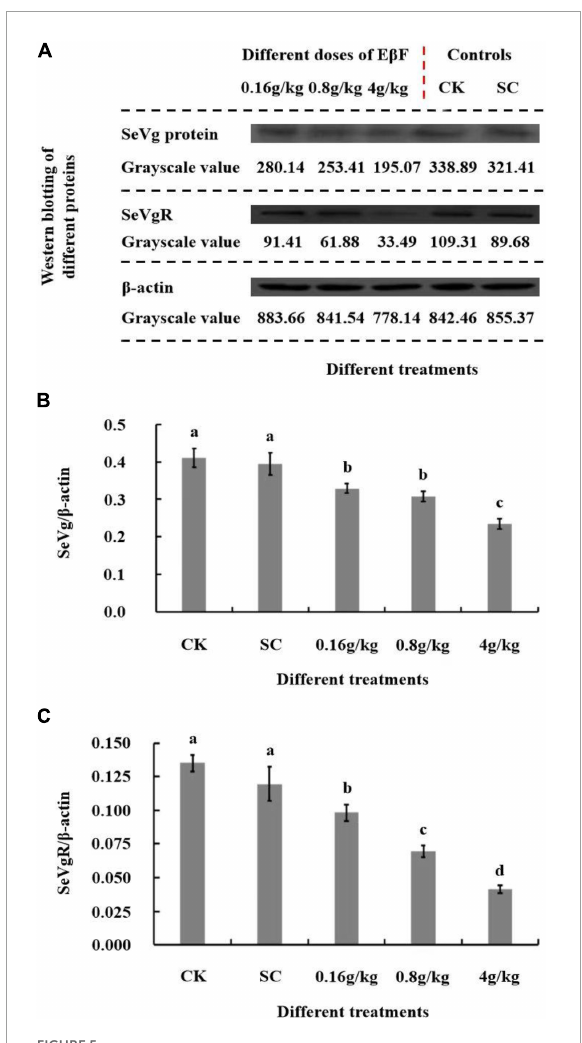
FIGURE5 The Western blot assay showed the relative expressions of SeVg and SeVgR proteins in female adults of S. exigua after E β F treatments at different doses. (A) The Western blot pictures of SeVg and SeVgR proteins in female adults of S. exigua after E β F treatments at different doses. (B,C) The relative expressions of SeVg and SeVgR protein expressions by calculating the grayscale value ratios of SeVg/ β -actin and SeVgR/ β -actin with different treatments. CK (blank control) and SC (solvent control) were set as controls. The concentrations of E β F treatments were set as 0.16, 0.8, and 4 g/kg; the units of g/kg in all treatment groups mean the mass ratio of E β F/artificial diet. Different lower-case letters indicated a significant difference determined